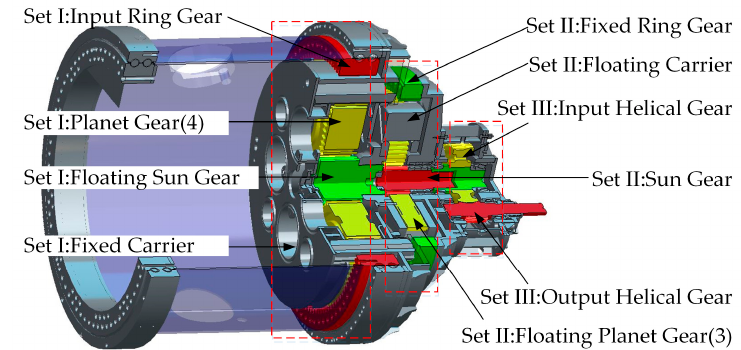
Figure 4. 3D drivetrain model of the 2 MW WTG.